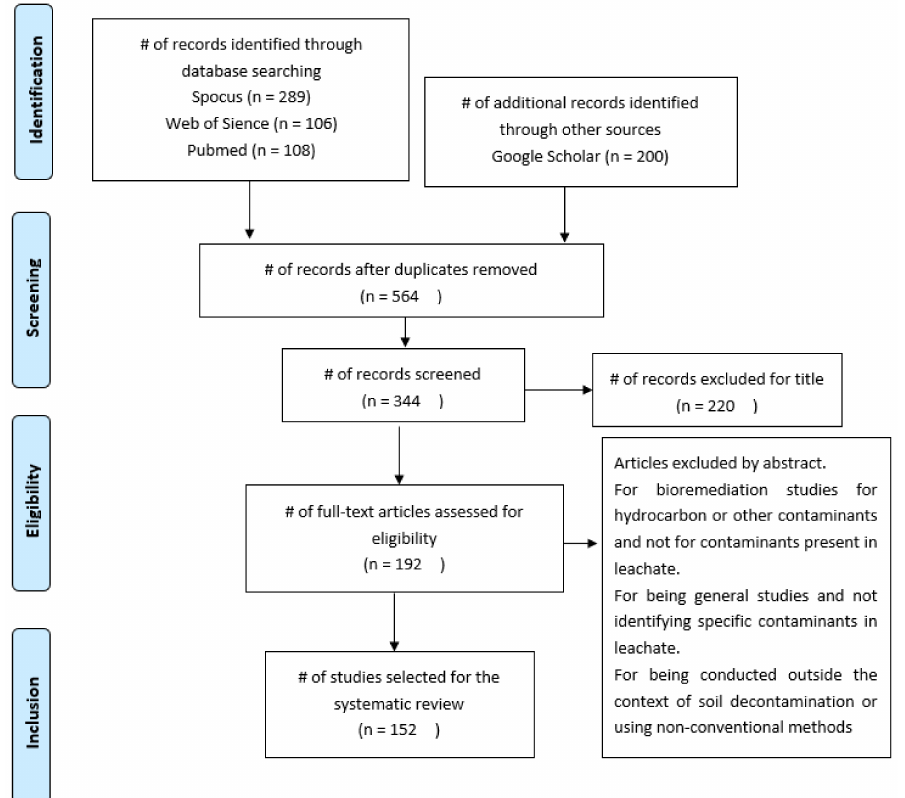
Figure 2. A diagram of the selected items, n is the number of articles. The complete list is shown in Supplementary Material Table